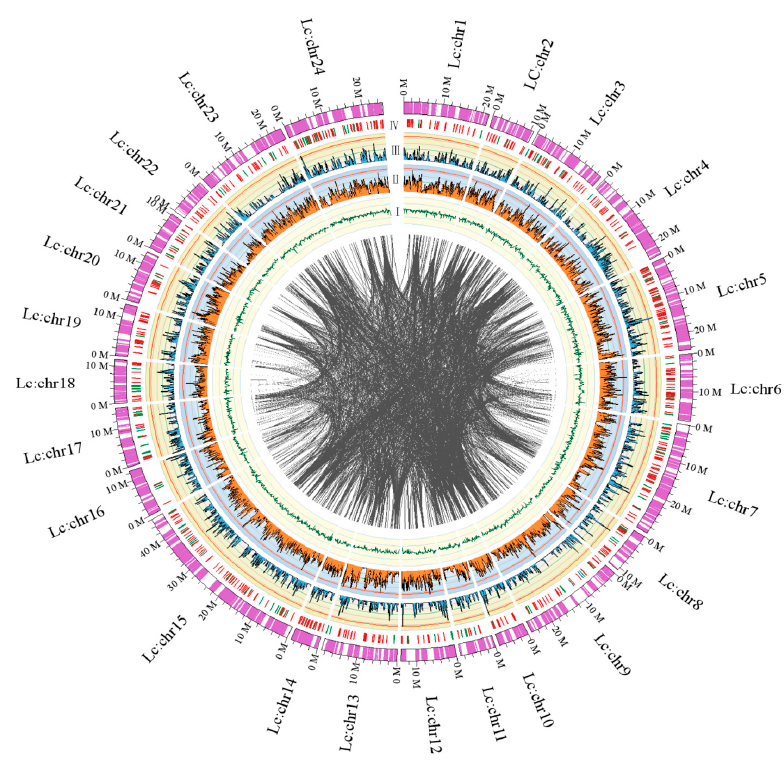
Figure 2. Circos atlas representation of the chromosome scaffold assembly information. The most external circle represents the length of each pseudo-chromosome. From inside to the outside ring: ( I ) GC content of 100-kb genomic interval. Each colored line represents a colinear match between two chromosomes; ( II ) Density of SNP distribution of 100-kb genomic interval; ( III ) Density of gene distribution of 100-kb genomic interval; ( IV ) Distribution of genes involved in immunity and hypoxia adaptation. The line colors of this ring were similar to those of Figure 1.